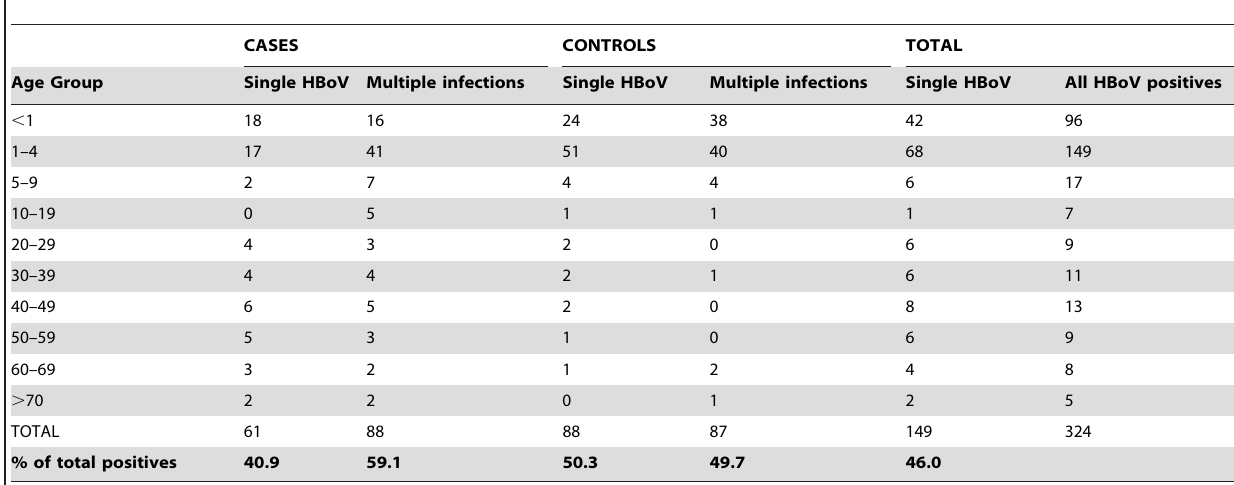
Table 3. Distribution of HBoV-positive samples in cases and controls with or without a co-infection.